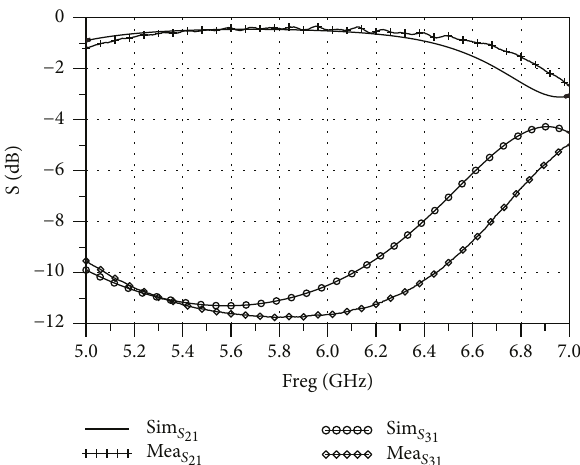
Figure 11: Comparisons of S 21 and S 31 between the electromagnetic simulation in ADS and measurement.